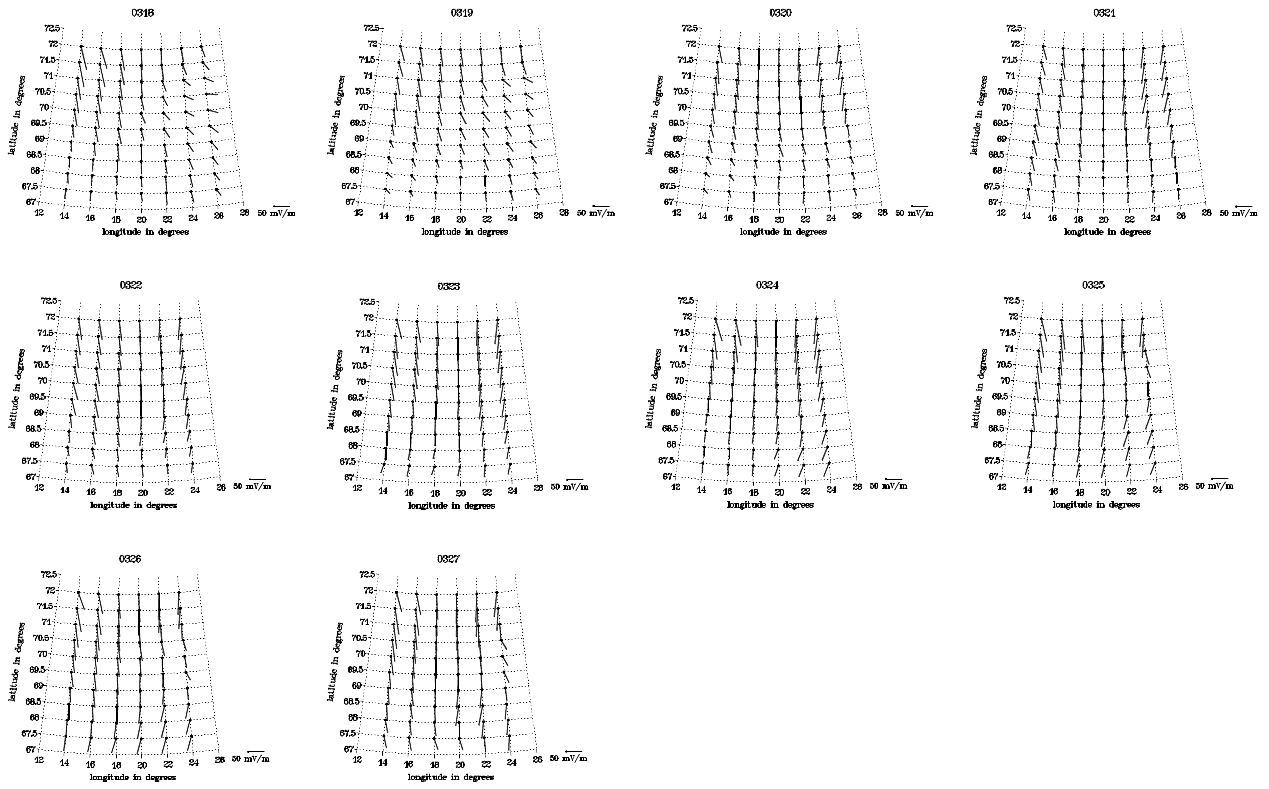
Fig. 5. Electric field measurements of the STARE